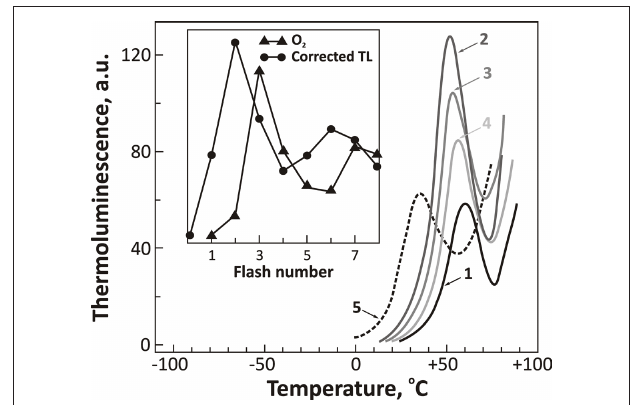
FIgurE 8 | Thermoluminescence intensity from a thermophilic cyanobacterium Synechococcus vulcanus as a function of single-turn over actinic flashes at a flash frequency of 1 Hz (flash numbers correspond to curves 1, 2, 3, and 4, respectively). The dashed curve 5 is the spectrum obtained in the presence of DCMU that blocks electron transport from Q A − to Q . Insert shows flash number dependence of the 53 ° C TL band, B the B band, due to S /S and Q B − recombination (closed circles), and that of 2 3 oxygen evolution (closed triangles). The “Q” band, due to S and Q A − 2 recombination (curve 5) was obtained at 35 ° C in this organism. The figure was modified and reproduced from Govindjee et